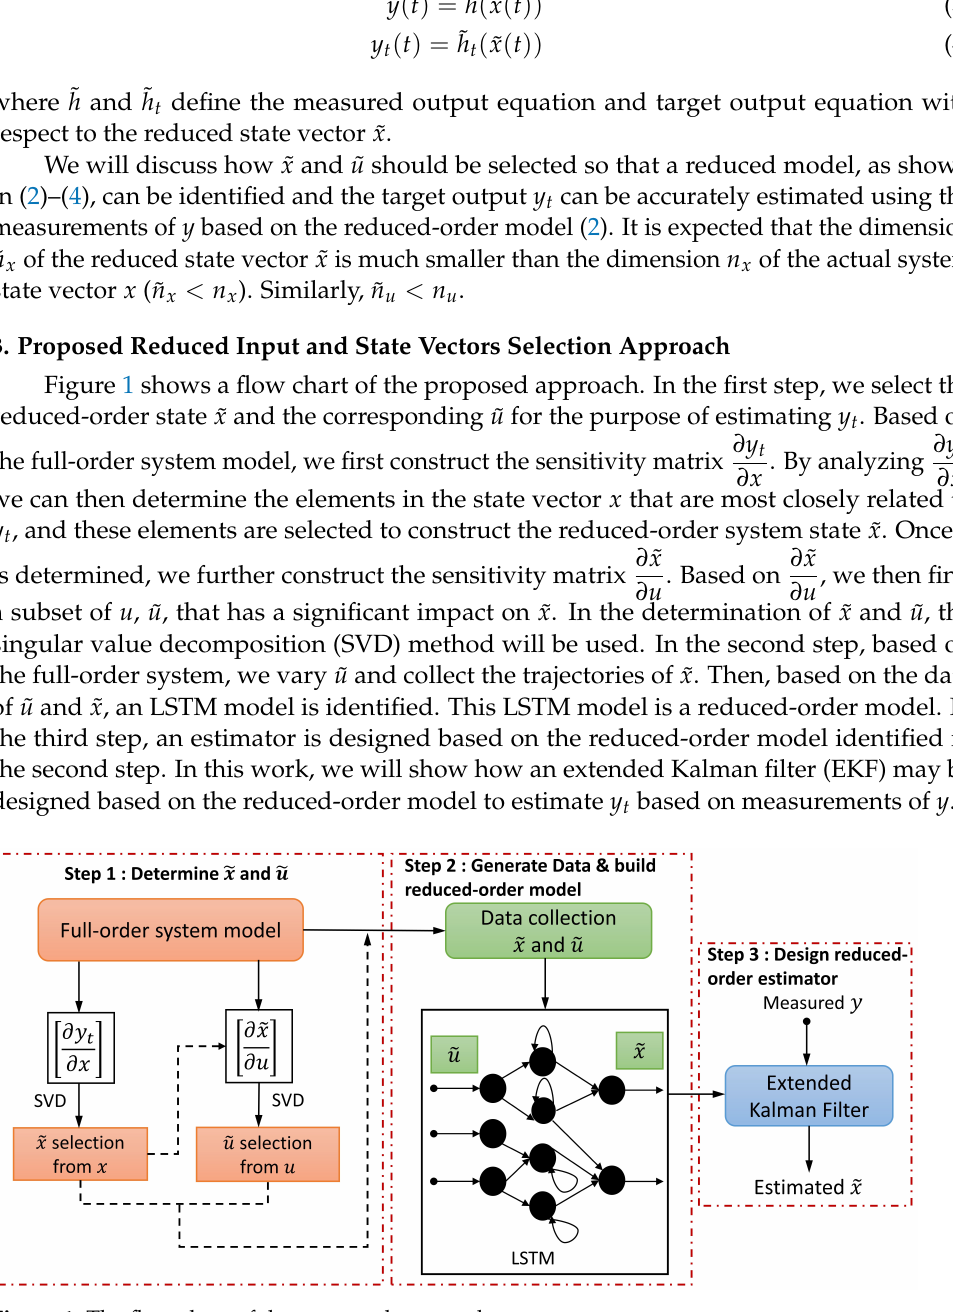
Figure 1. The flow chart of the proposed